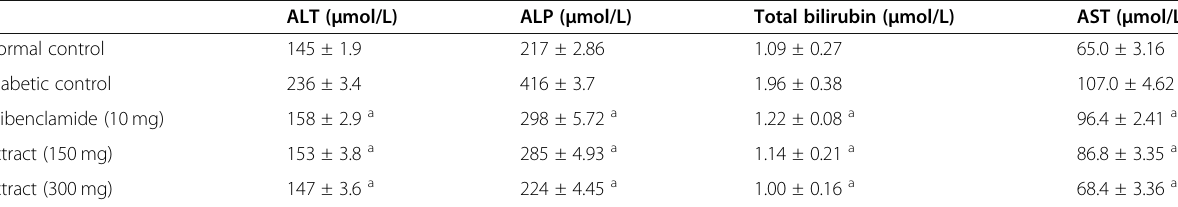
Table 5 The potency of methanolic extract of rhizomes of Sorghum halepense (L.) Pers to normalize the level of ALT, ALP, AST and total bilirubin in serum